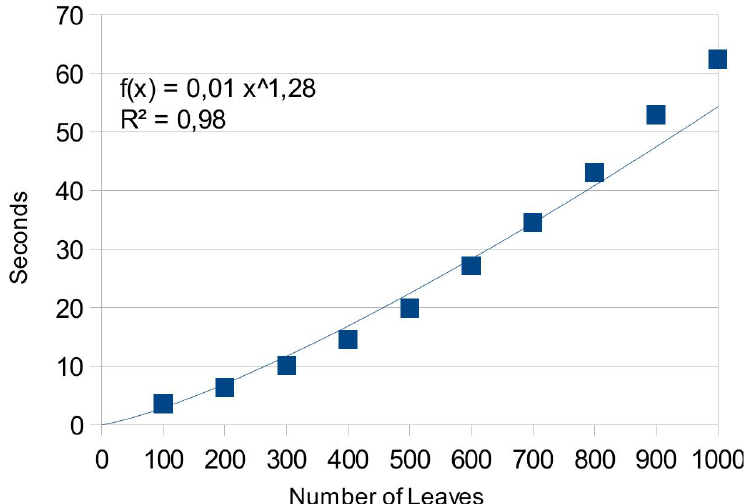
Figure 2: Time required for the verification of a set of probabilistic formulas with respect to the number of tips in the